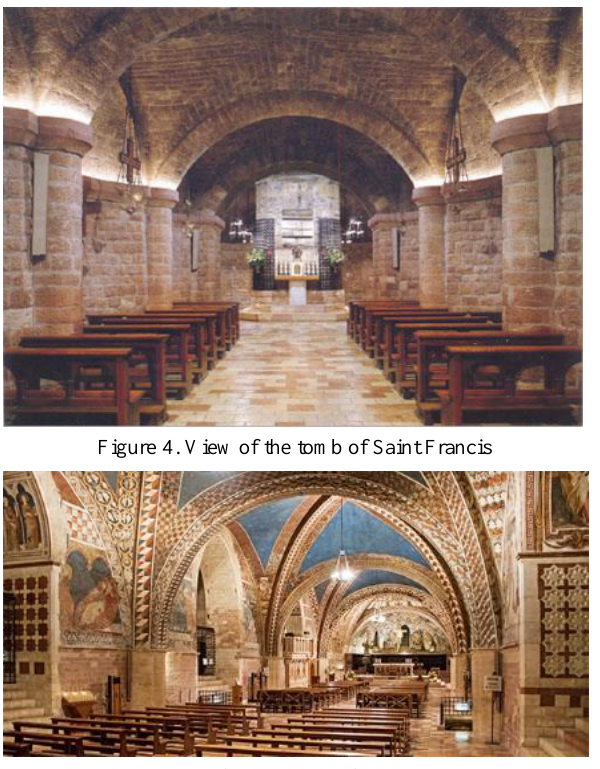
Figure 5. View of the interior of the lower